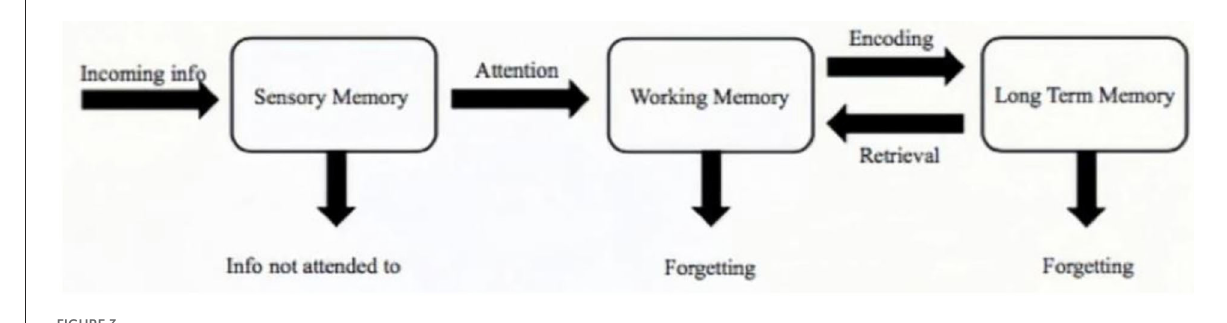
FIGURE3 Information processing